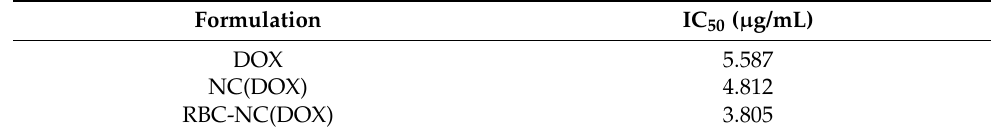
Figure 4. ( a ) The cytotoxic effects of different DOX formulations on 4T1 cells. ( b – d ) The uptake of different DOX preparations by 4T1 cells using a confocal laser scanning microscope. ( b ) Free DOX, ( c ) NC(DOX), ( d ) RBC-NC(DOX). Error bars represent standard deviations (n = 3). ** and *** indicate p < 0.01 and p < 0.001, respectively. Table 1. IC 50 values of different formulations against 4T1